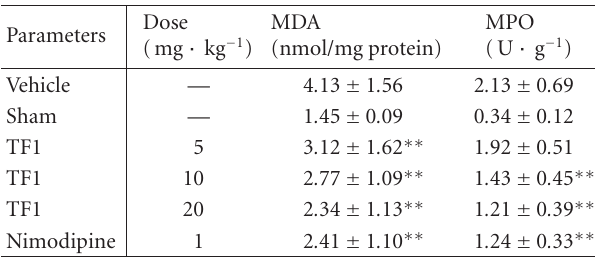
Table 1: E ff ect of theaflavin on MDA and MPO activities ( x ± s n =